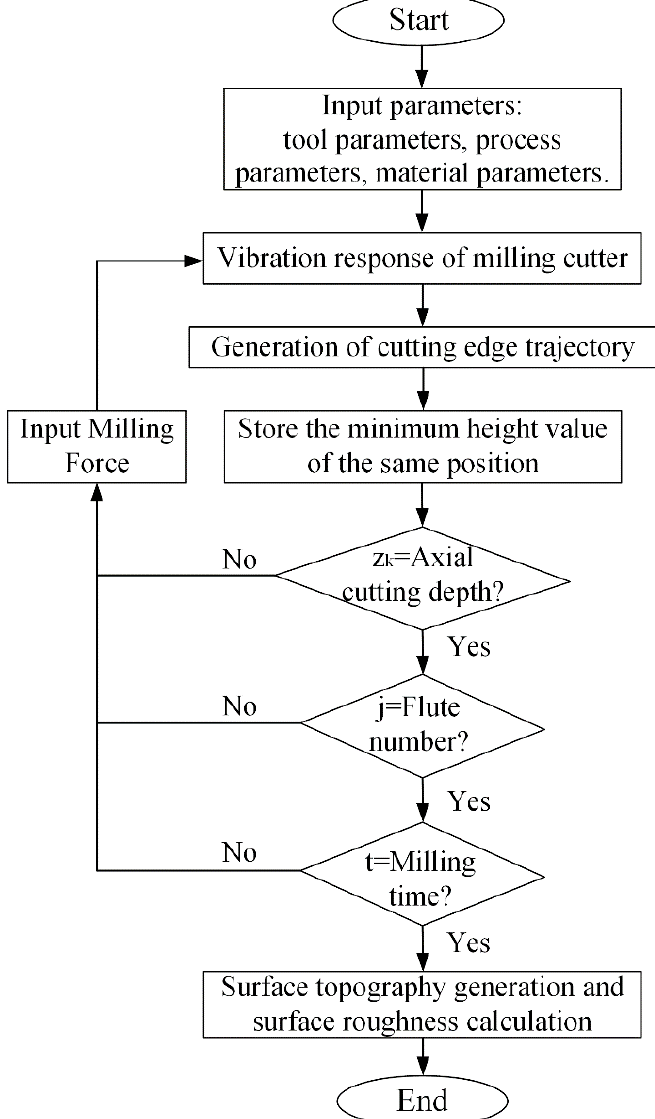
Figure 26. The modeling process of surface roughness.